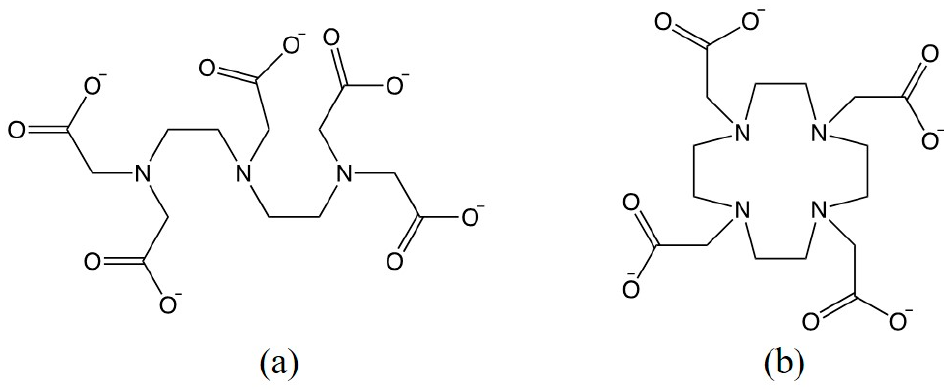
Figure 2. Structures of DTPA ( a ) and DOTA ( b ).